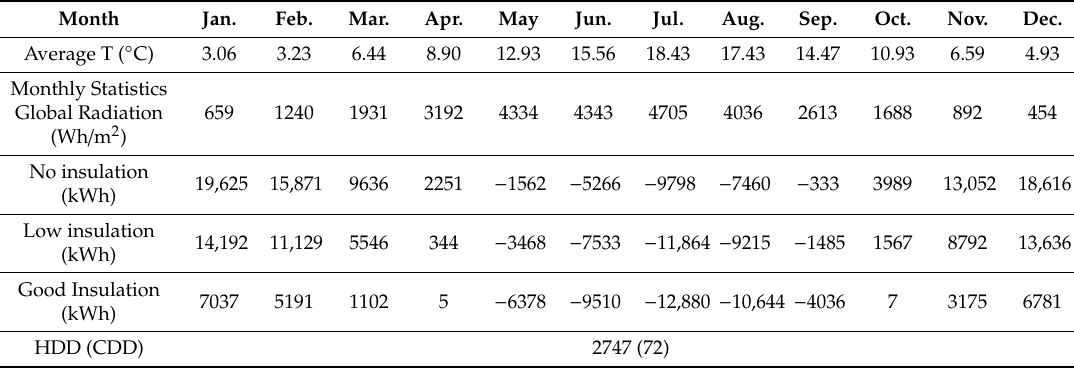
Figure 3. Hourly sensible load of the average monthly day for Building 3. Athens (Csa) climate conditions: ( a ) Heating conditions and no insulation, ( b ) heating conditions and low insulation, ( c ) heating and good insulation, ( d ) cooling condition and no insulation, ( e ) cooling condition and low insulation, ( f ) cooling condition and good insulation. Table 4. Average monthly climatic data and energy demand of Bruxelles.